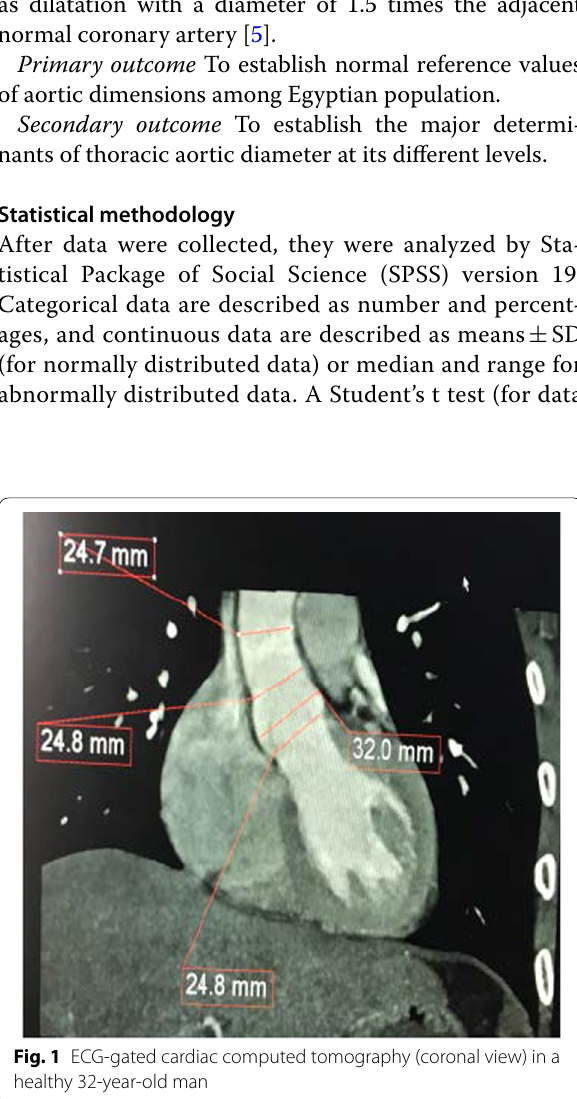
Fig. 2 ECG‑gated cardiac computed tomography (axial view) of the descending thoracic aorta and the pulmonary artery in a healthy